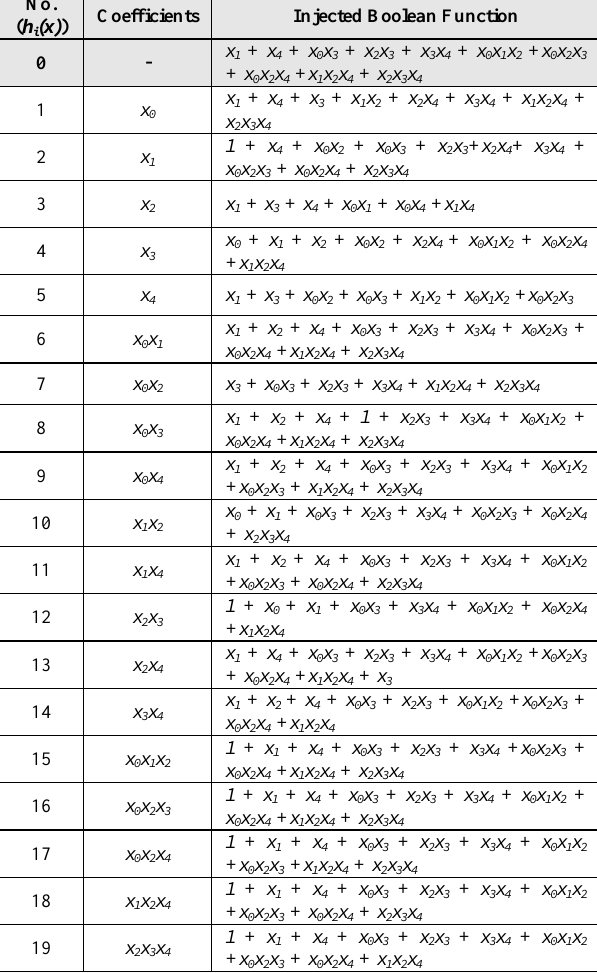
Table 1 : List of Injected Grain v0’s Boolean function